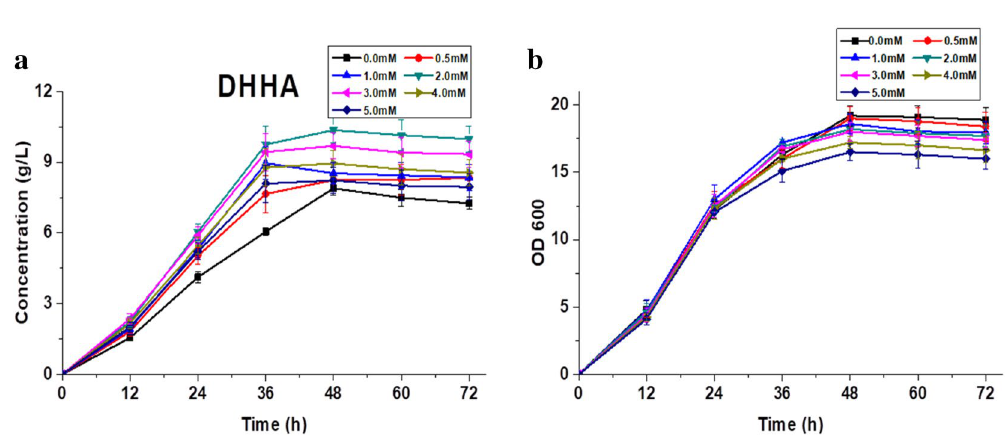
Figure 6. The DHHA production, growth curves of P. chlororaphis LDA-5 after different concentrations of Fe 3+ adding. ( a ) The DHHA production and (b) growth